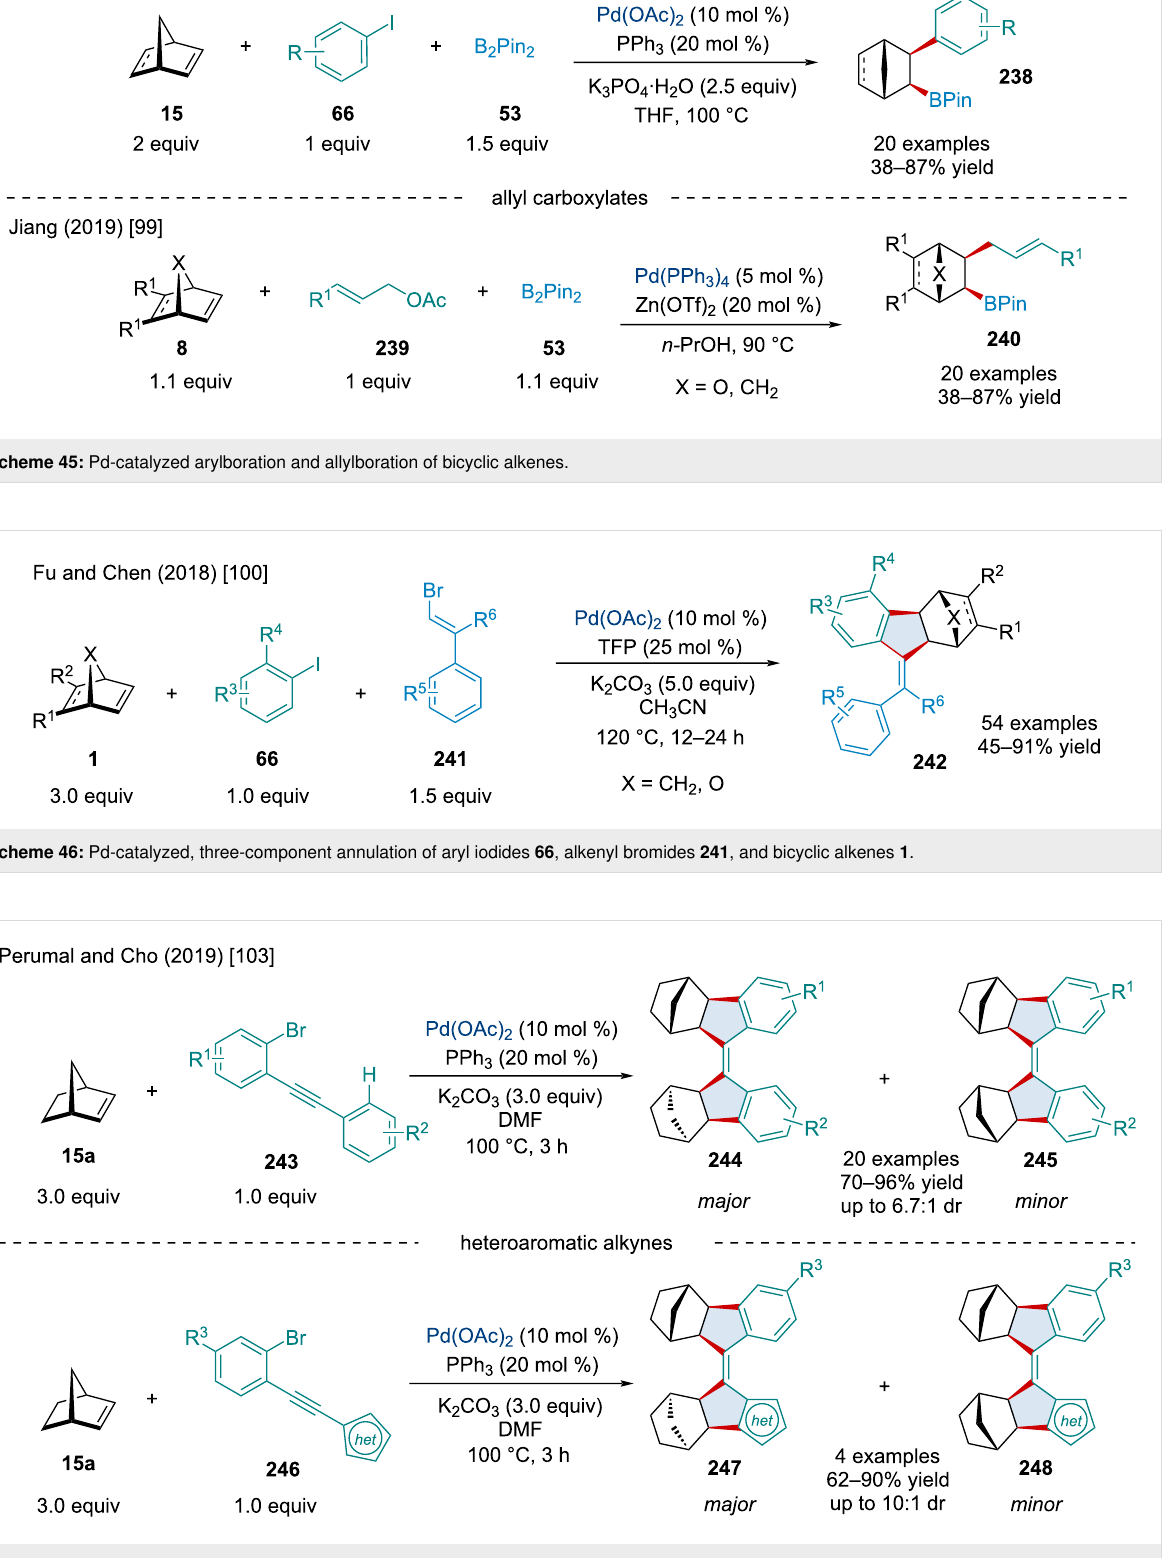
Scheme 47: Pd-catalyzed double insertion/annulation reaction for synthesizing tetrasubstituted